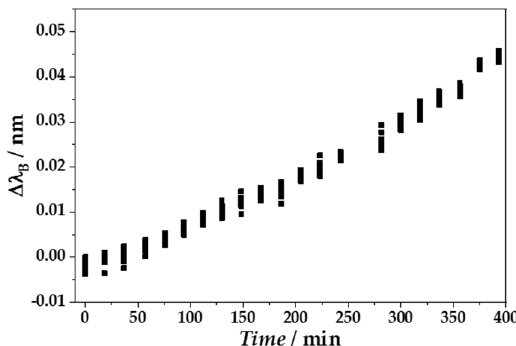
Figure 10. Online monitoring of ∆ λ B of one representative CRP-sensitive eFBG fiber during the application of a CRP concentration series (7.8 × 10 − 19 –8.7 × 10 − 12 M) in 20 concentration steps over a time period of 375 min. For each CRP concentration, 10 reflection spectra were recorded subsequently (black dots).